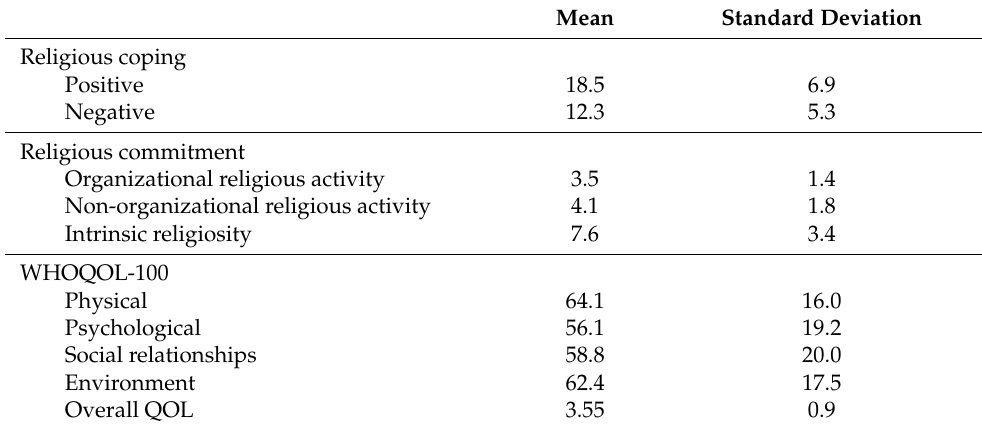
Table 2. Religious commitment, religious coping, and WHOQOL-100 domain scores.